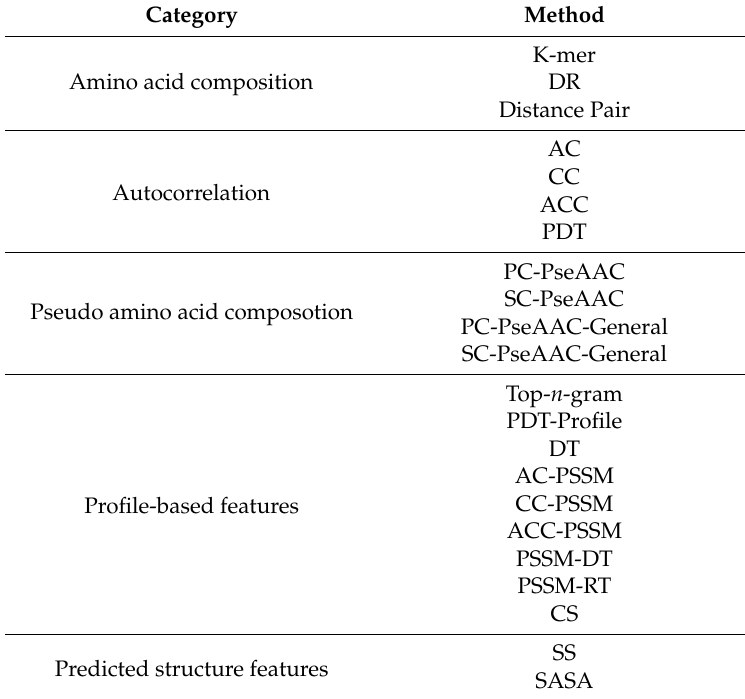
Table 7. Pse-in-one feature extraction method of protein